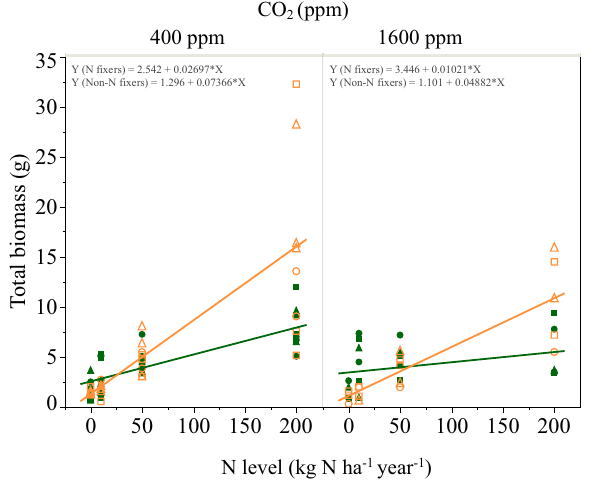
Figure 1. The response of nitrogen fixing (green, solid symbols) and non-N fixing (orange, open symbols) plant groups to the increasing soil N level at 400 and 1600 ppm CO 2 (P = 0.006, F = 8.03 for the interaction between N and CO 2 level; P < 0.0001, F = 28.22 for the interaction between the plant group and nitrogen level). Species symbols: A. rugosa —green round, A. rubra —green triangle, A. crispa —green square, B. glandulosa —orange round, B. papyrifera —orange triangle, B. pumila —orange square.